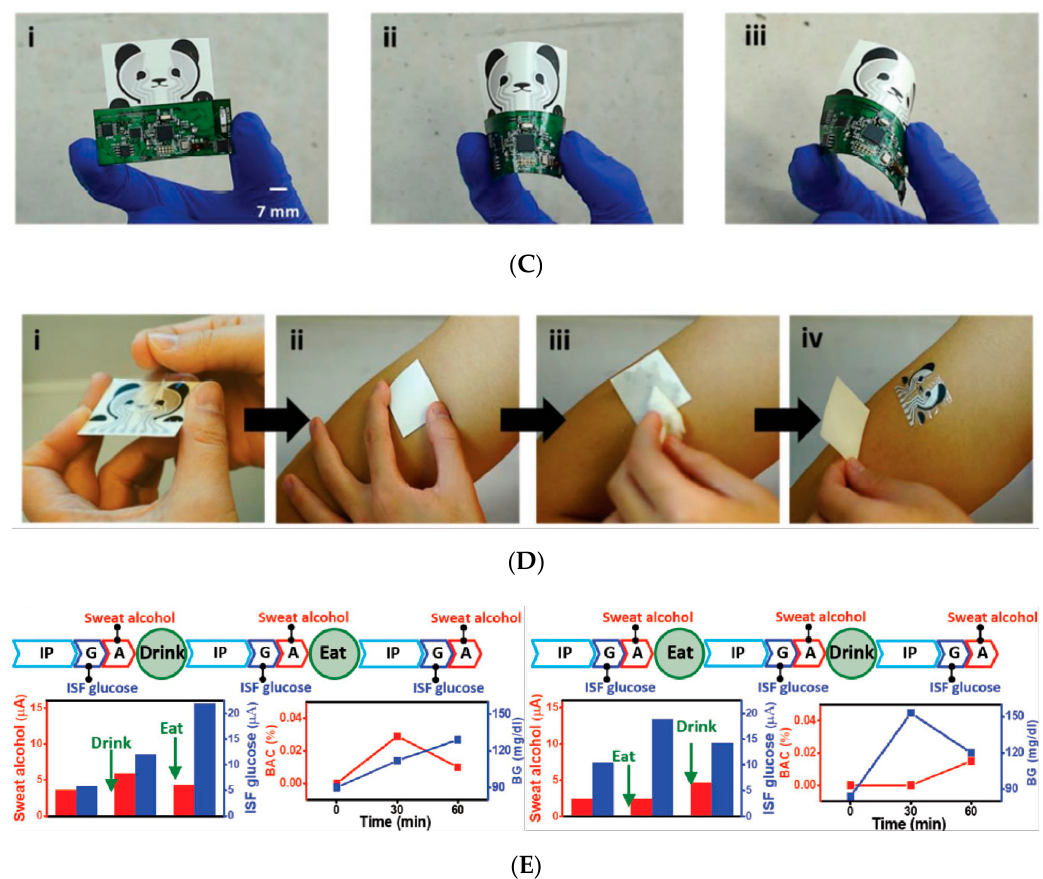
Figure 9. ( A ) Scheme of iontophoretic delivery of pilocarpine and iontophoretic extraction of glucose. ( B ) Screen-printed biosensor coupled with wireless flexible printed circuit board. The left-hand site is dedicated to alcohol sensing while the right-hand side is dedicated to glucose. White scale bar: 7 mm. ( C ) Demonstration of the flexibility of the overall device (board + sensors). ( D ) Tattooing the sensor part. ( E ) Sensing performance after meal then alcohol intake (left) or alcohol then meal intake, compared with blood glucose and breath alcohol. Reproduced from [39]. © 2018 the authors. Published by WILEY-VCH Verlag GmbH & Co. KGaA, Weinheim. https: // creativecommons.org / licenses / by / 4.0 / .